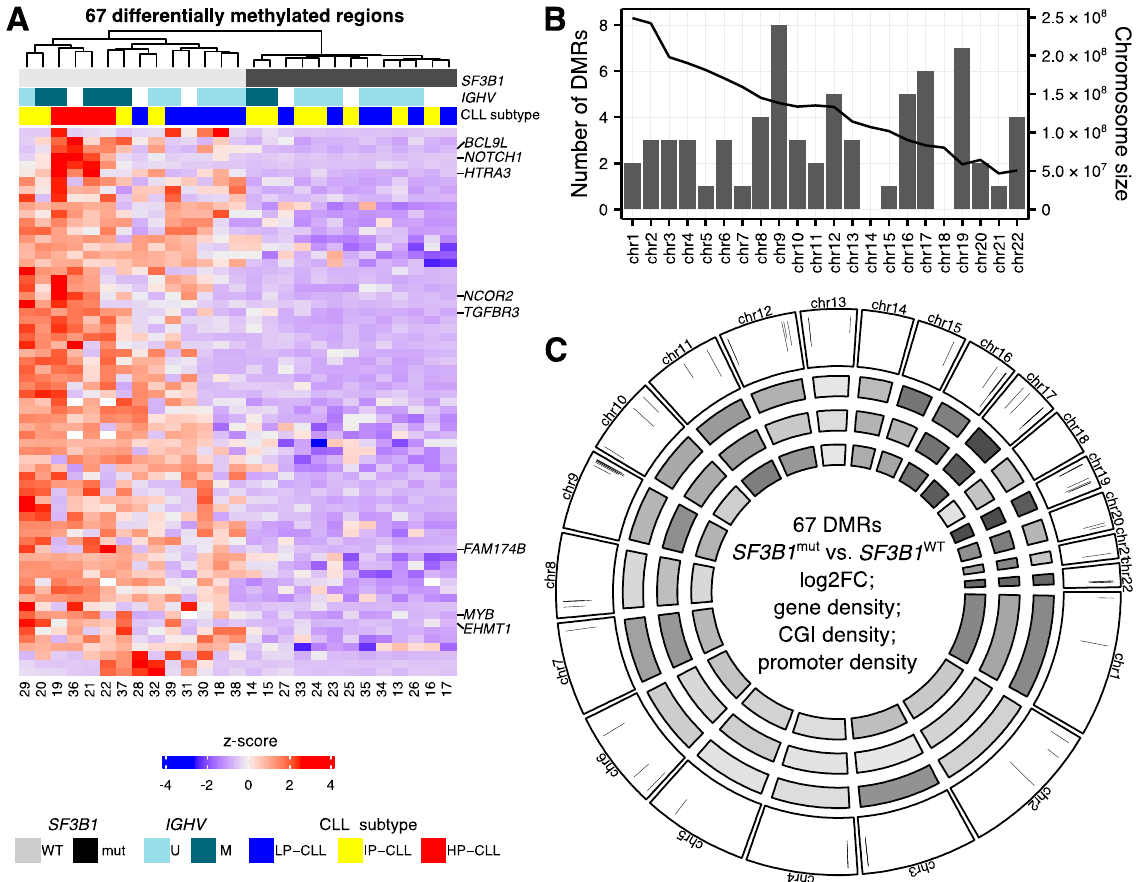
Figure 2. Differentially methylated regions (DMRs) in chronic lymphocytic leukemia (CLL) patients with SF3B1 mutation. ( A ) Methylation levels of 67 DMRs between CLL patients with and without SF3B1 mutation. The samples were clustered based on Euclidean distances with a complete linkage agglomeration method. White cells in the IGHV annotation denote missing information. CLL-subtype was defined by Oakes et al. based on the 18 loci selected by the authors [25]: low- programmed (LP-CLL), intermediate-programmed (IP-CLL), and high-programmed (HP-CLL). See Figures 4 and S7. ( B ) Numbers of DMRs between CLL patients with and without SF3B1 mutation identified per chromosome. ( C ) Circos plot with the outer panel showing the log2 fold change in the 67 DMRs between SF3B1 mut and SF3B1 WT CLL patients in a − 3.7 to 0.2 range. The next three panels show, from outside to inside, the average density of 250 bp regions tested for differential methylation per chromosome within (i) genes; (ii) CpG islands (CGI); (iii) gene promoters. The darker the grey color, the higher the density.